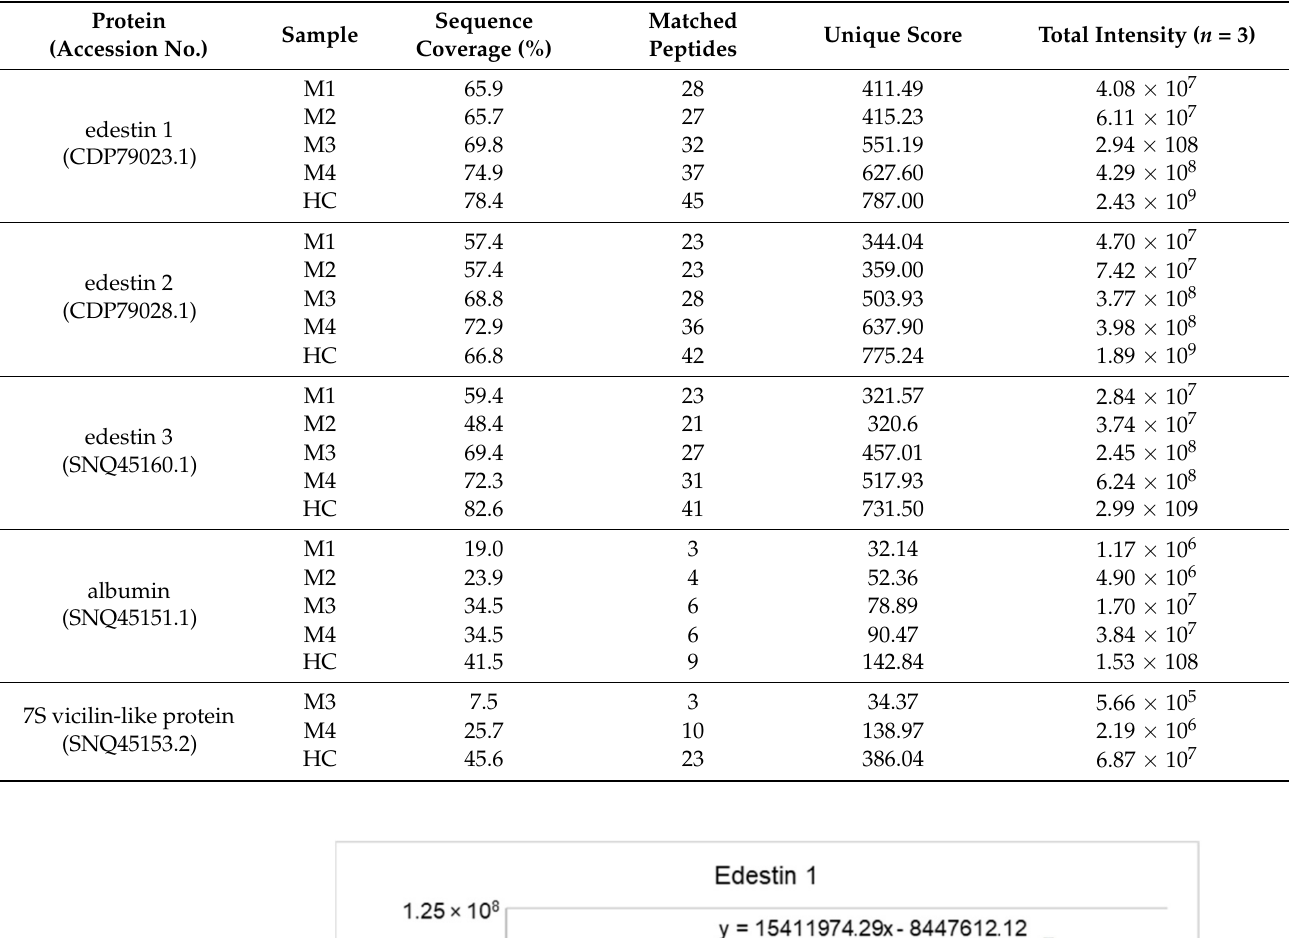
Table 2. Hemp-seed-specific proteins identified in hemp cake and cooked meatballs using LC-QTOF-MS/MS.